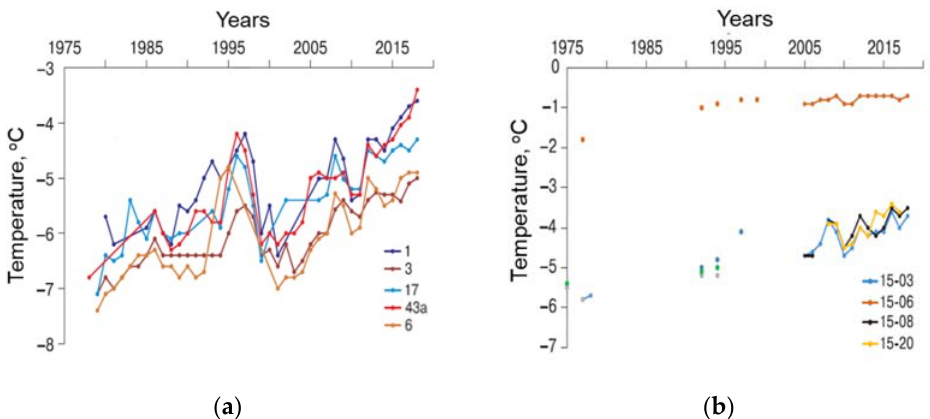
Figure 6. Variations of mean annual permafrost temperatures at the depth of zero annual amplitudes, from temperature logs at Marre–Sale ( a ) and North Urengoi ( b ), zones of typical and southern tundra, respectively [85]. Numbers on legends indicate borehole numbers. Single temperature measurements (grey and green points) are made in unnumbered wells.